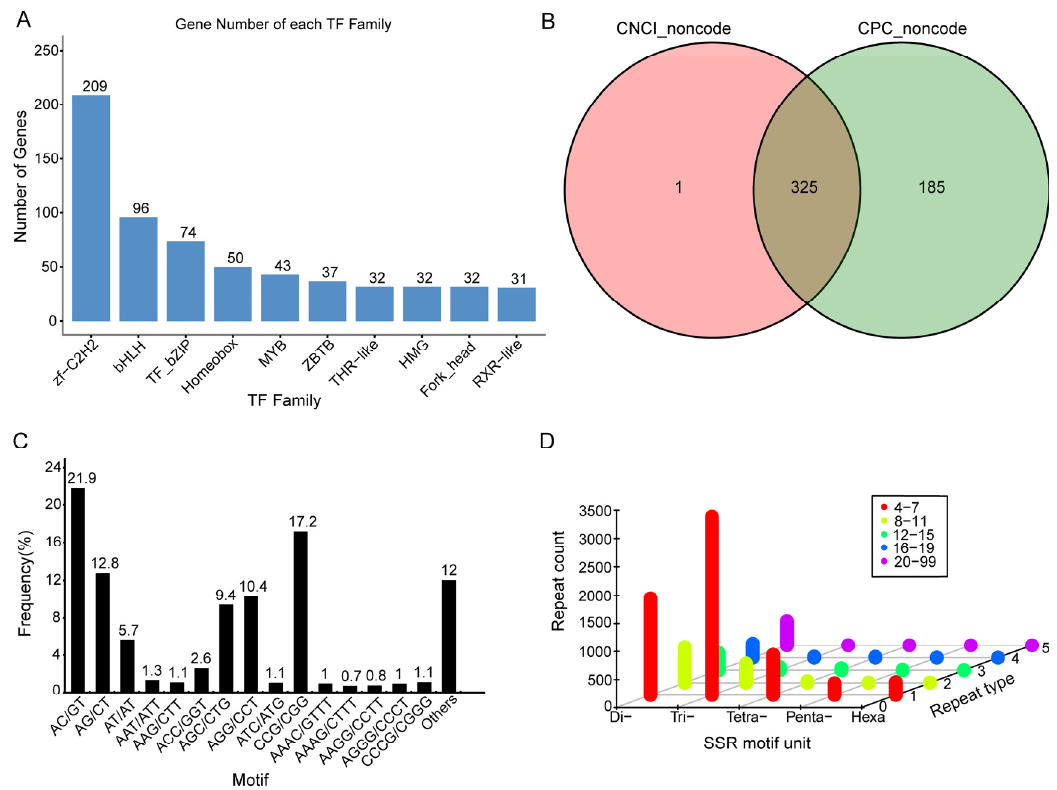
Figure 4. Results of structural analysis for M. pilosus . ( A ) The number and family of TFs were predicted by SMRT. ( B ) Venn diagram of lncRNAs predicted by CNCI and CPC methods. ( C ) The proportion of SSRs of different tandem repeat unit types in total SSRs. ( D ) Distribution of SSR types.